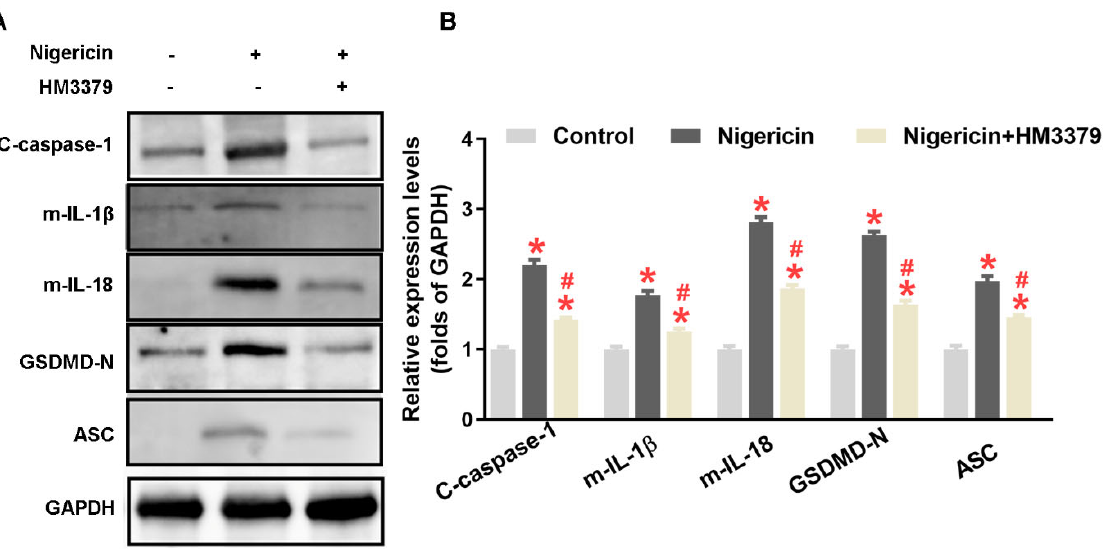
Figure 5. HM3379 inhibited pyroptosis through NLRP3 inflammasome pathway in BV2 cells. ( A ) The expression levels of NLRP3 inflammasome and pyroptosis-related proteins, such as cleaved caspase-1, mature IL-1 β , mature IL-18, GSDMD-N, and ASC. ( B ) The effect of nigericin, a NLPR3 activator, on the above protein expressions in BV2 cells stimulated with LPS and followed by HM3379 treatment. Data are presented as mean ± SEM. * indicates p < 0.05 vs. control, # indicates p < 0.05 vs. nigericin. N = 3 per group. LPS, lipopolysaccharide.